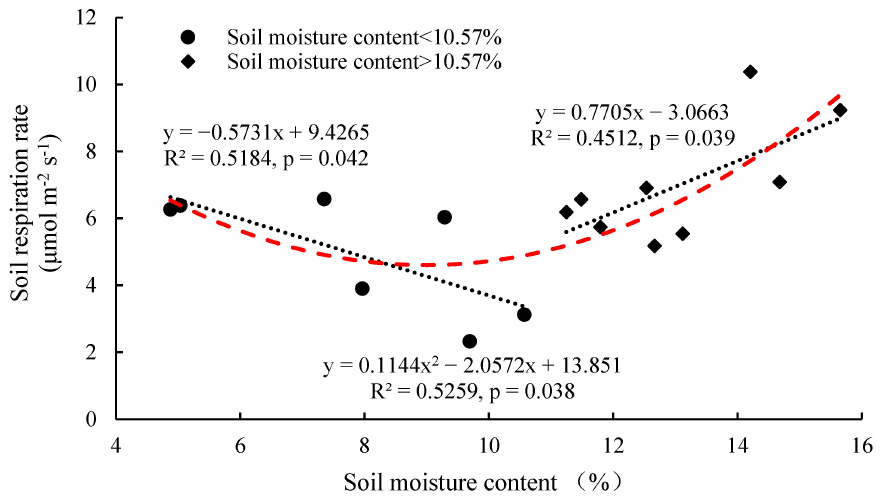
Figure 4. The relationship between soil moisture content and soil respiration rate.